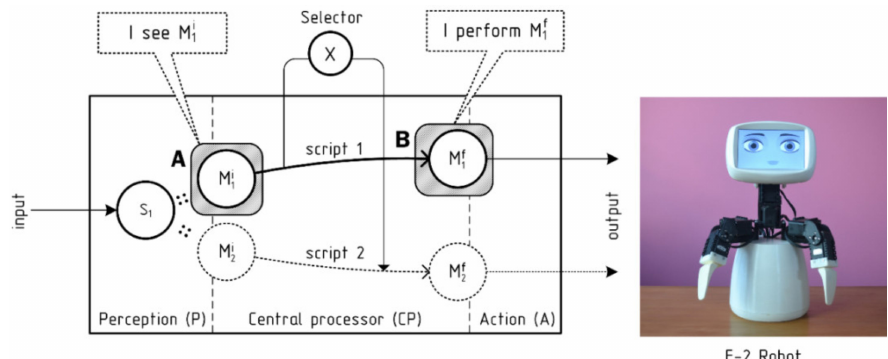
Figure 1. The general processing architecture of the F-2